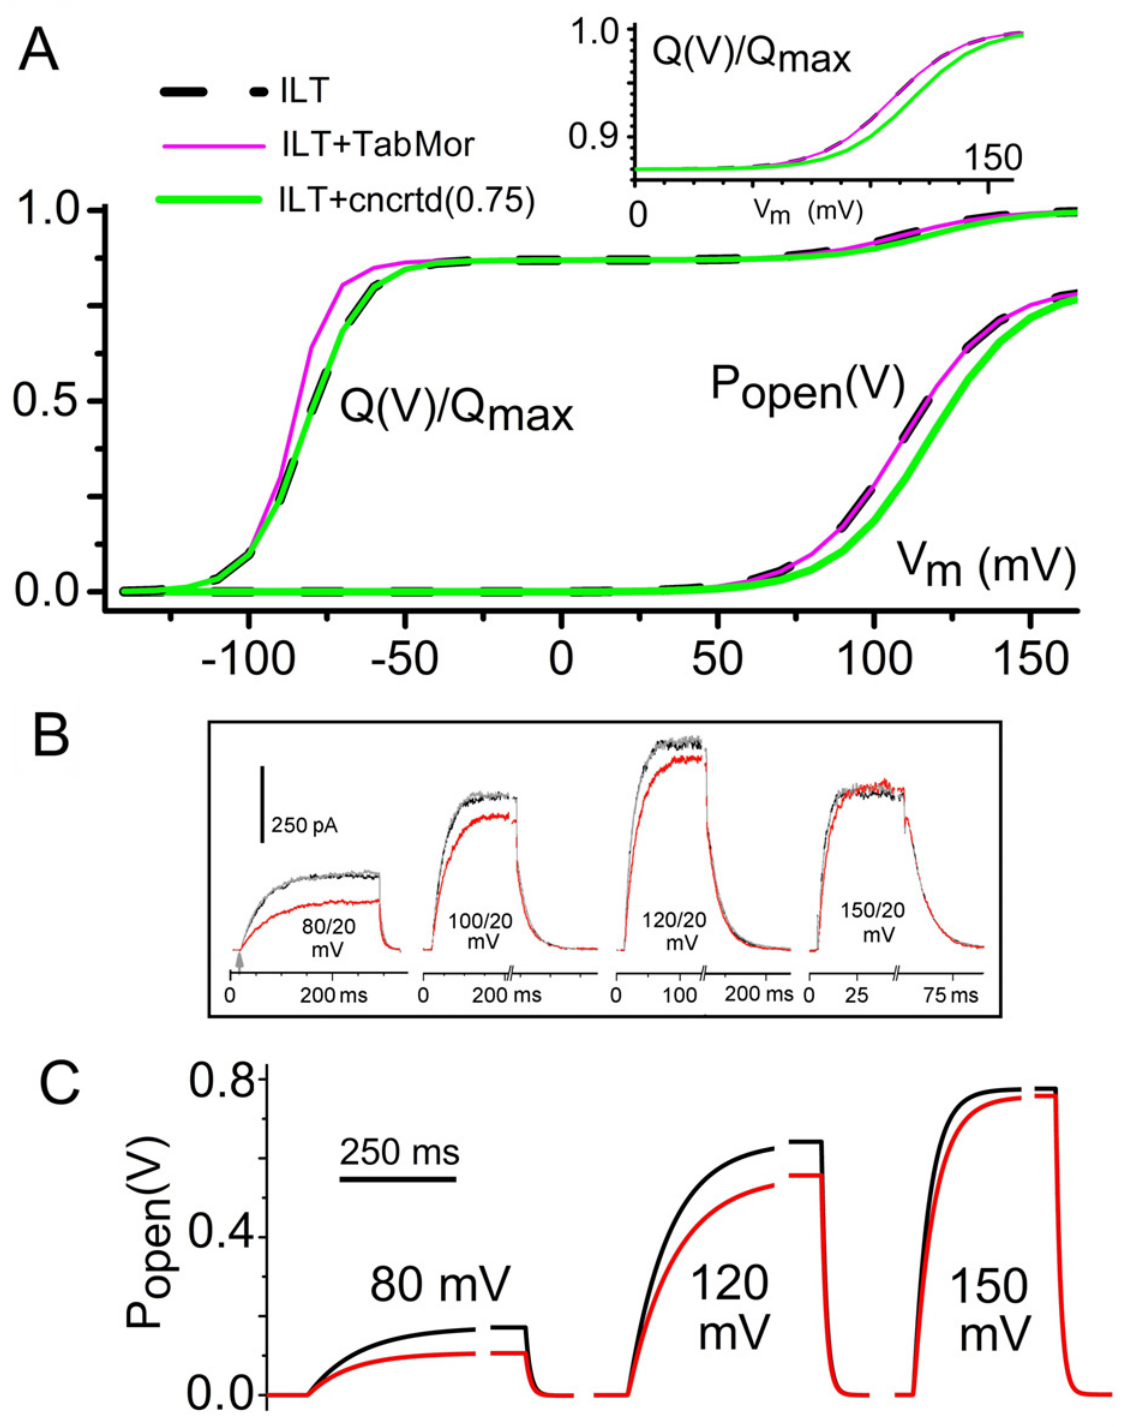
Fig 7. A 7-state vMS model of Shaker ILT: Q(V) , g(V) , and time courses. The four independent V-dependent transitions account for 87% [50] of charge movement and the concerted V-dependent closed-closed transition accounts for the remaining 13% [63],[59],[15]. Kinetic constants are Table 2. A . For a Scheme 3 Kv-ILT model, the Q(V)s for rest tension (dashed black line) and with applied tension acting on the concerted transition (green) ( Q(V) from 0 to 150 mV is expanded above). To illustrate that any “ stretch effects ” on V-dependent transitions prior to C 5 $ C 6 would be uncoupled from the ILT- g(V) , an ILT simulation (pink line) using the same “ TabMor ” parameters as previously (Fig. 4B) was included (Note that P open (V) = g(V)/g max ). Comparison of B